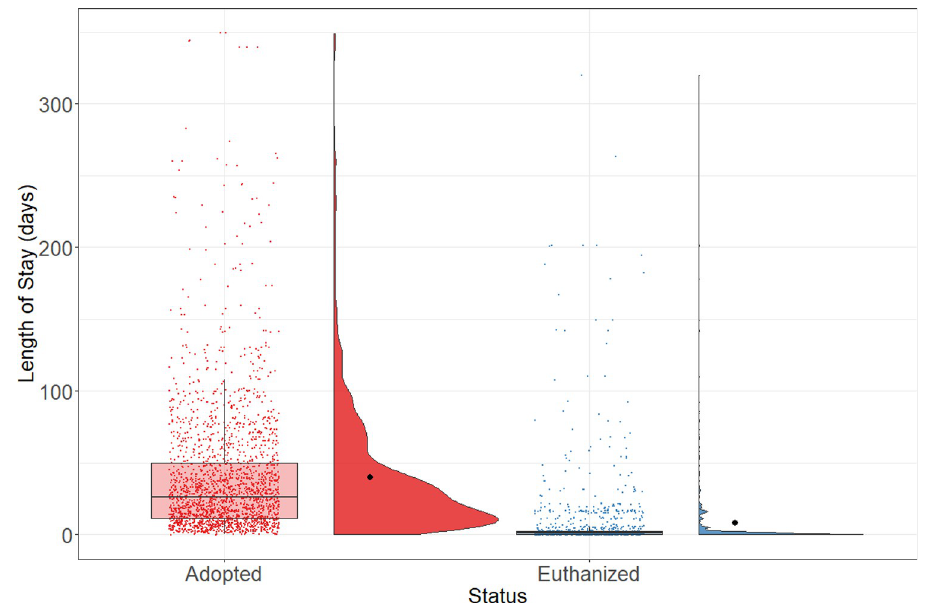
Fig 2. LOS by outcome. Boxplots represent the median, the 25 and 75 percentiles, with whiskers representing the 95 percentiles. Individual data is shown by dots on the boxplot. Additionally, the rain cloud plots show the distribution and the means in each